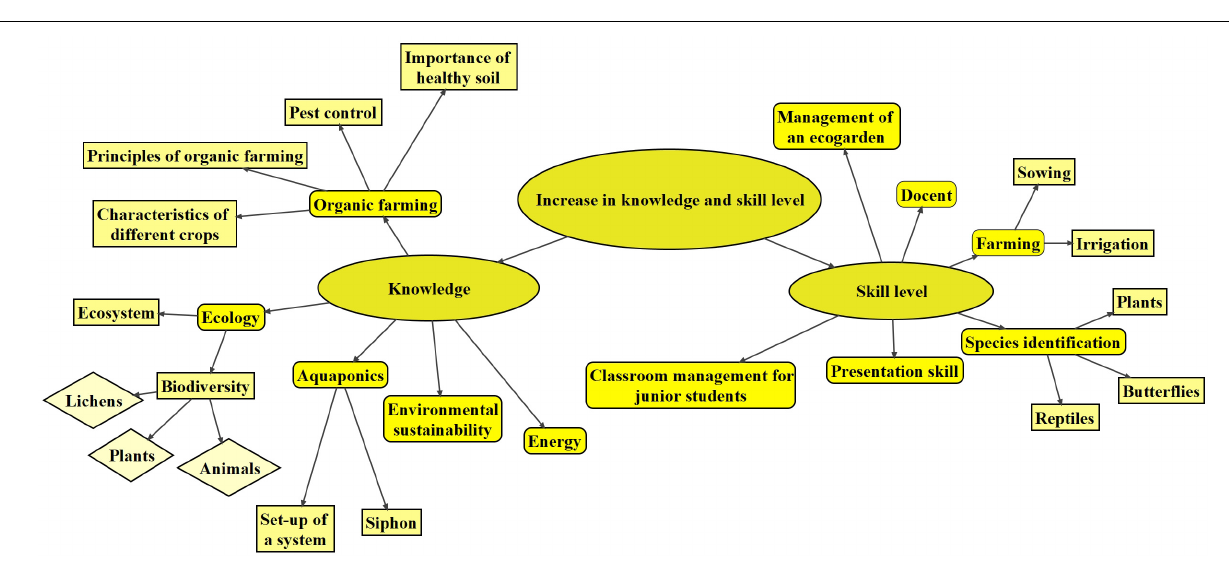
Frontiers in Psychology |